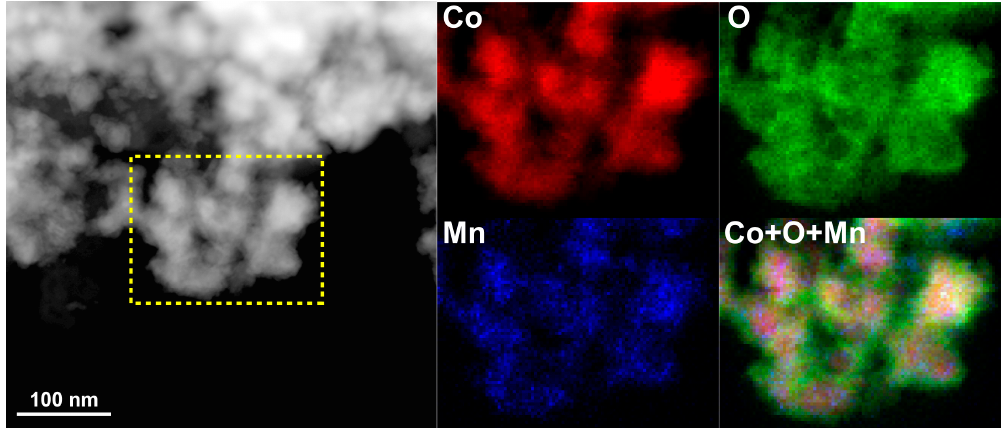
Figure A1. STEM image and EDS chemical maps of as ‐ fabricated NP ‐ Co before the in ‐ situ TEM study. The selected area shows the distributions of Co (red), O (green), and Mn (blue) from Co ‐ K, O ‐ K, and Mn ‐ K, respectively. The surface of the Co ligament was clearly oxidized.